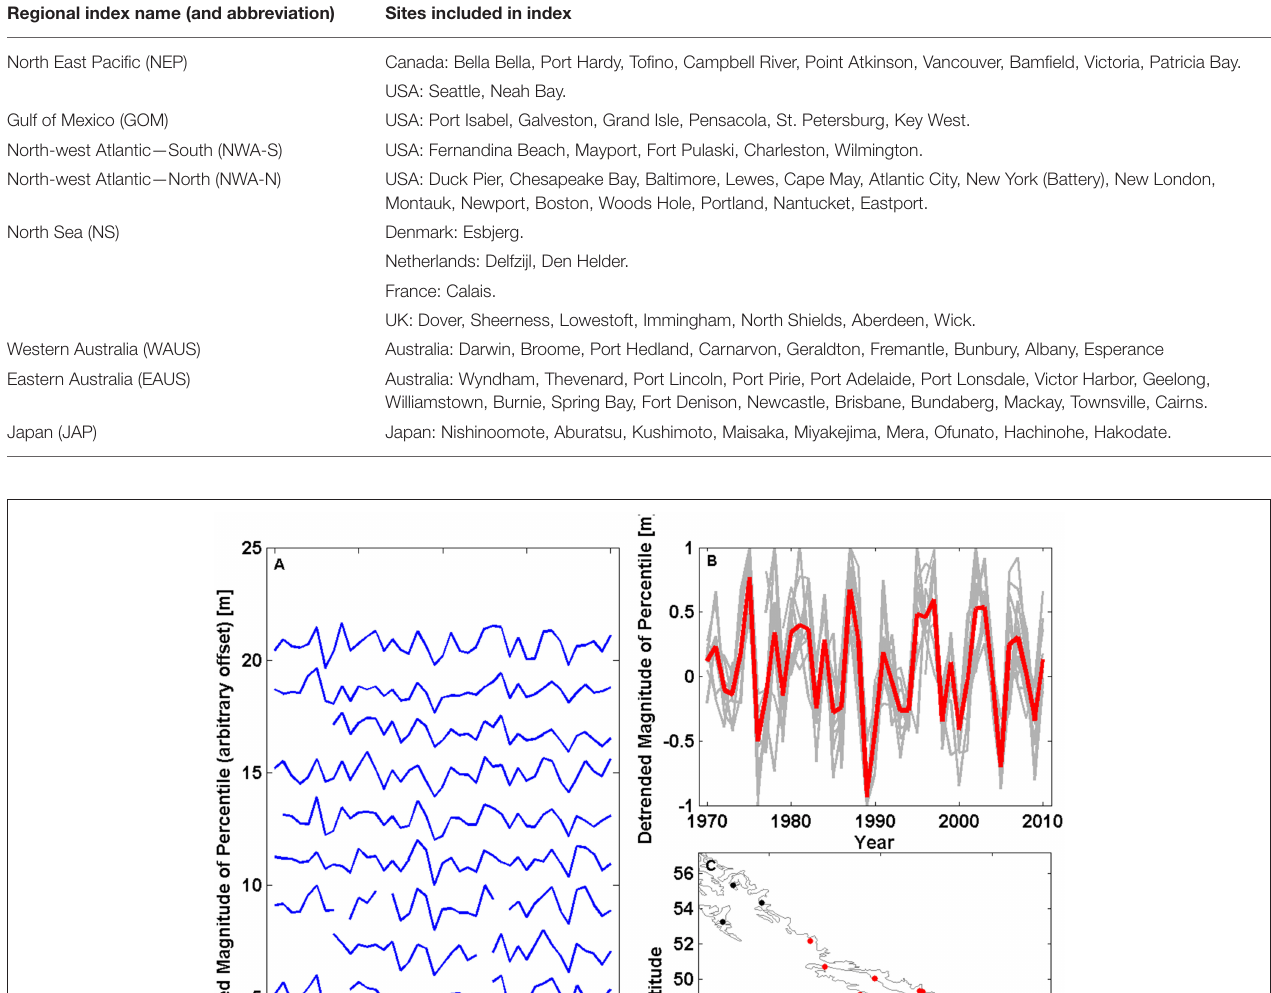
shown in Figure 9C , as red dots. Similar figures for the other 8 regions are shown in the Supplementary Material. There is considerable year-to-year variability in the 8 regional indices. To better investigate the inter-decadal variability we applied a Loess filter to each of the 8 regional skew surge indices, and the filtered time series are shown in Figure 10A . Concurrent peaks in skew surge are observed in multiple regions, most notably in 1992–1993 in the north-west Atlantic (North and South indices) and the North Sea. Peaks in skew surge in the southern North Atlantic throughout the 1990s appear to